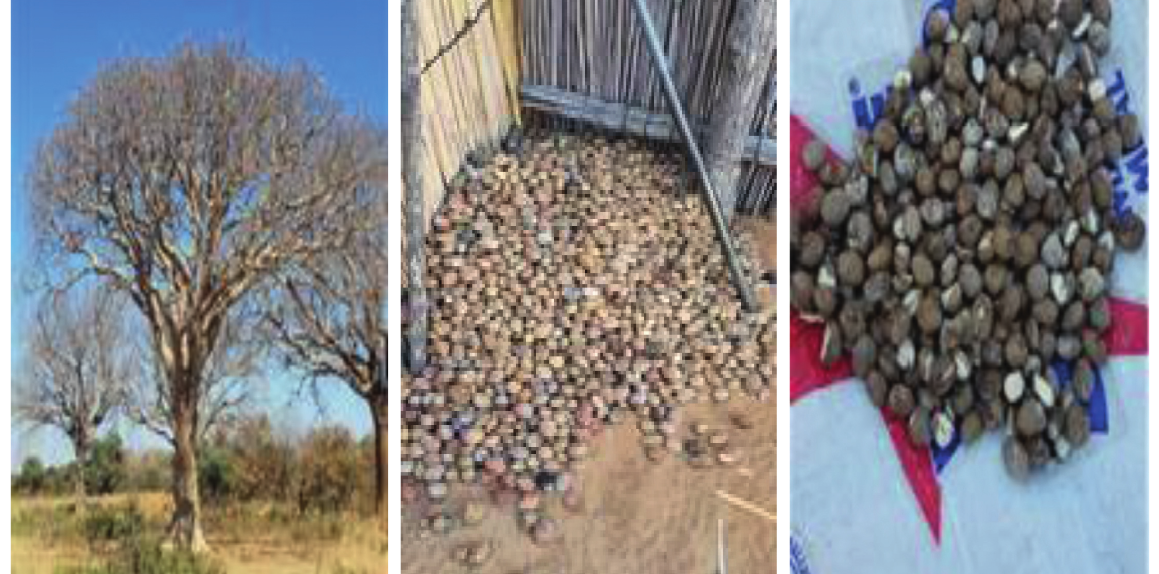
Figure 2: Photographic images of mongongo tress (a), mongongo fruit (b), and mongongo nuts